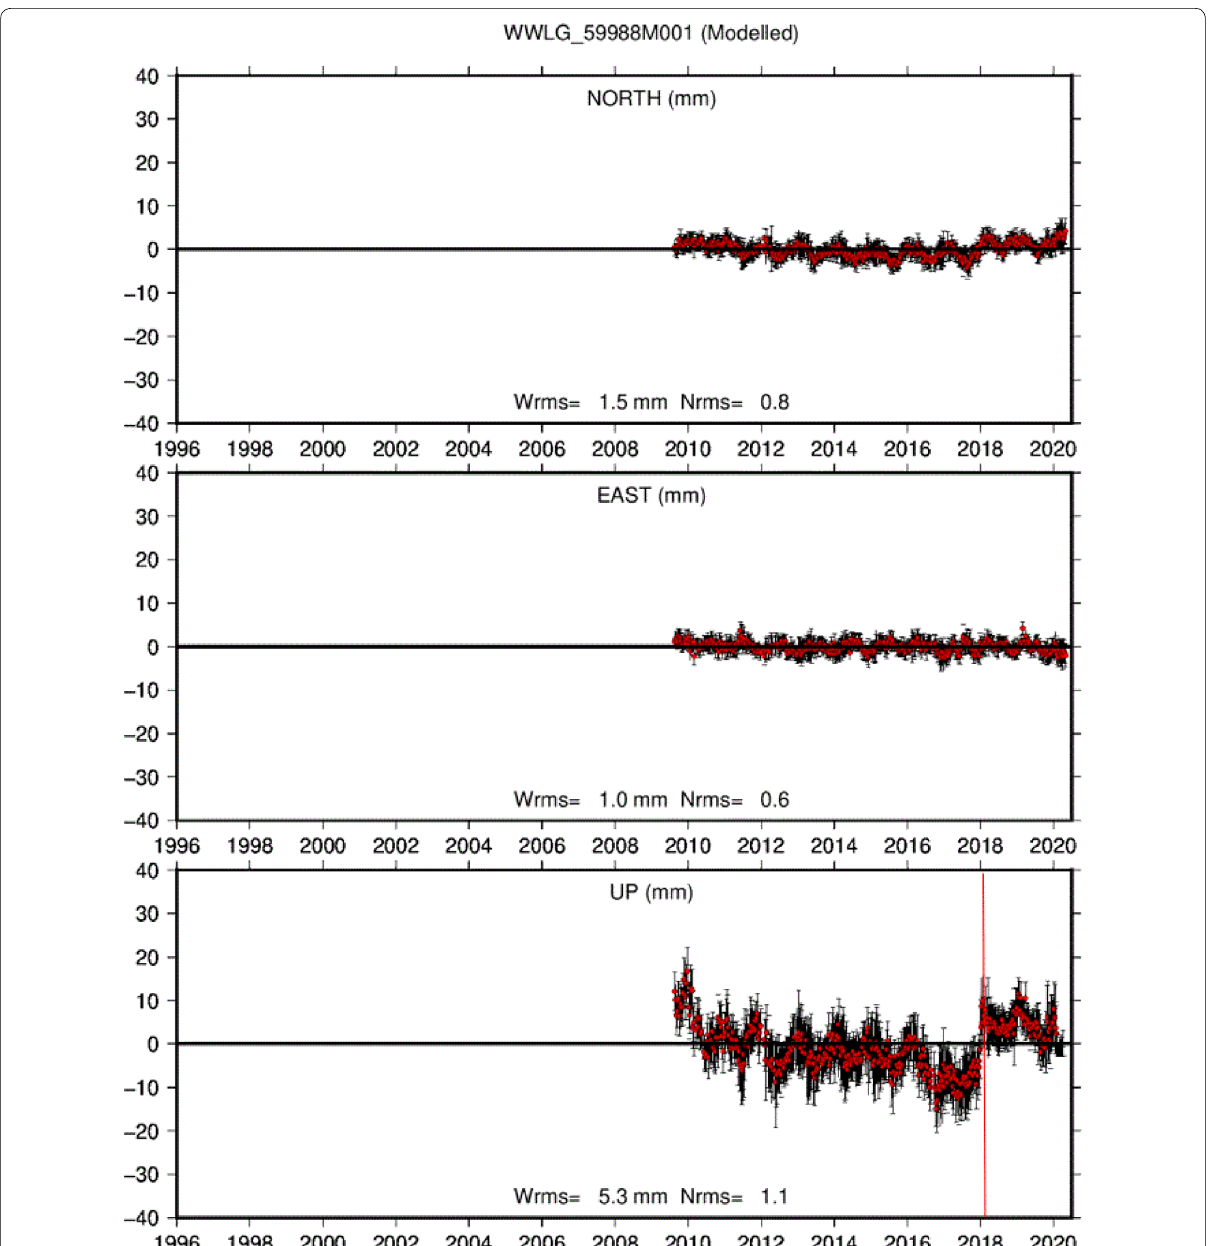
Fig. 6 The offset in the vertical component position time-series at station WWLG caused by damage to the antenna radome, the position time-series generated after removing the plate motion model and outliers as well as offset